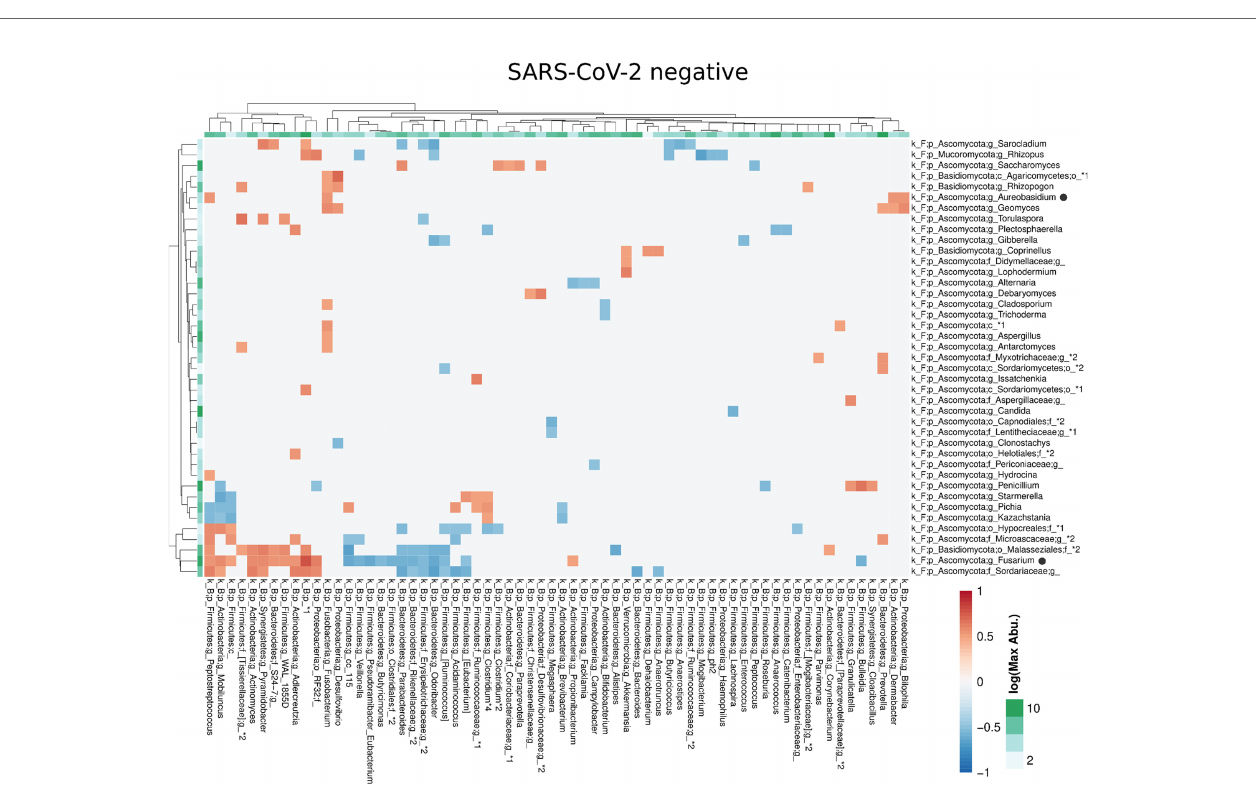
FIGURE 6 | Co-occurrence matrix visualizing the co-occurring genera between the fungal and bacterial kingdoms that exhibit positive (red) or negative (blue) correlations in SARS-CoV-2 negative patients. The colours of the scale bar denote the strength of the correlation with 1 indicating a perfect positive and -1 a strong negative correlation between the two co-occurring genera. The sidebars show the logarithm of the maximum abundance of the genera in the group. When two genera with the same taxonomy assignment were present that could only be identi fi ed to the family level or above this level, an asterixis and an identi fi er number was added to the name to distinguish the taxa. Black circles following the genus names indicate the genera which are discussed in the manuscript.